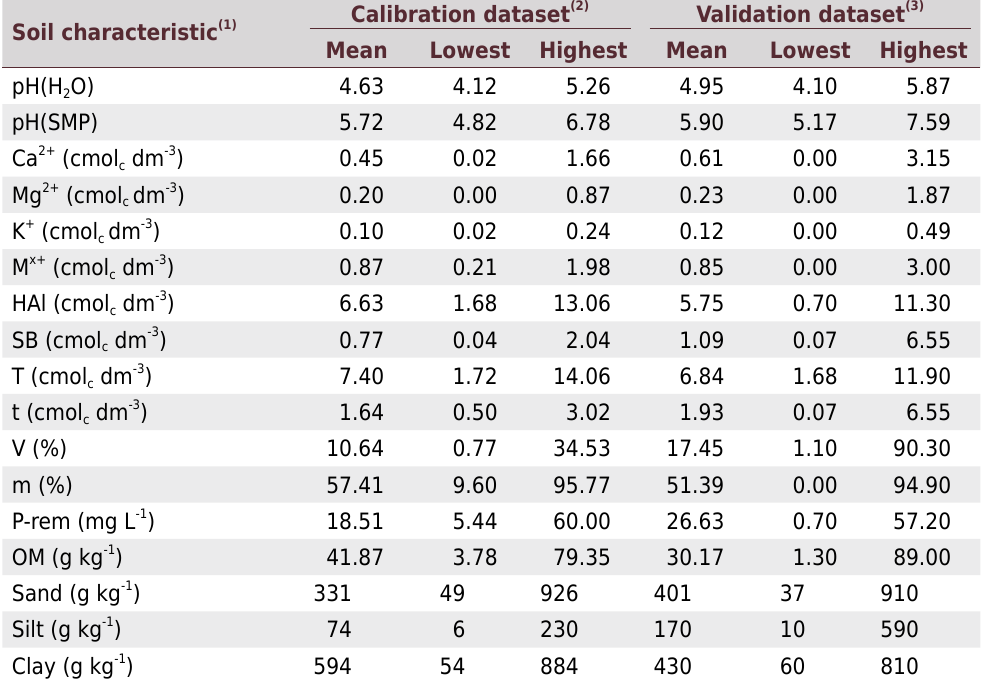
Table 2. Descriptive statistics for chemical and physical characteristics of the soils used to develop (calibration dataset) and validate (validation dataset) the new predictive models Soil characteristic